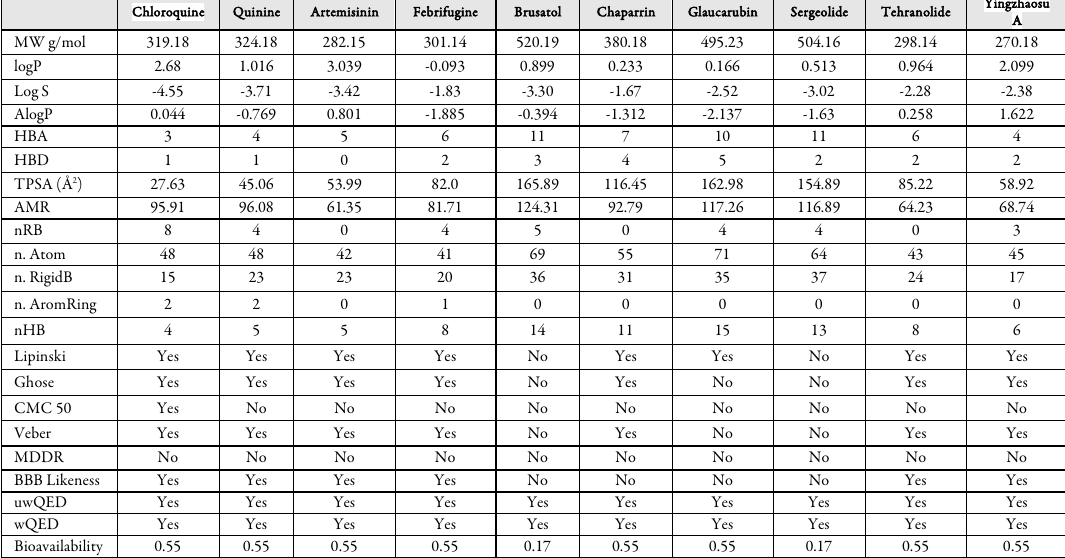
Table 3. Drug-likeness properties of studied phytochemicals Chloroquine